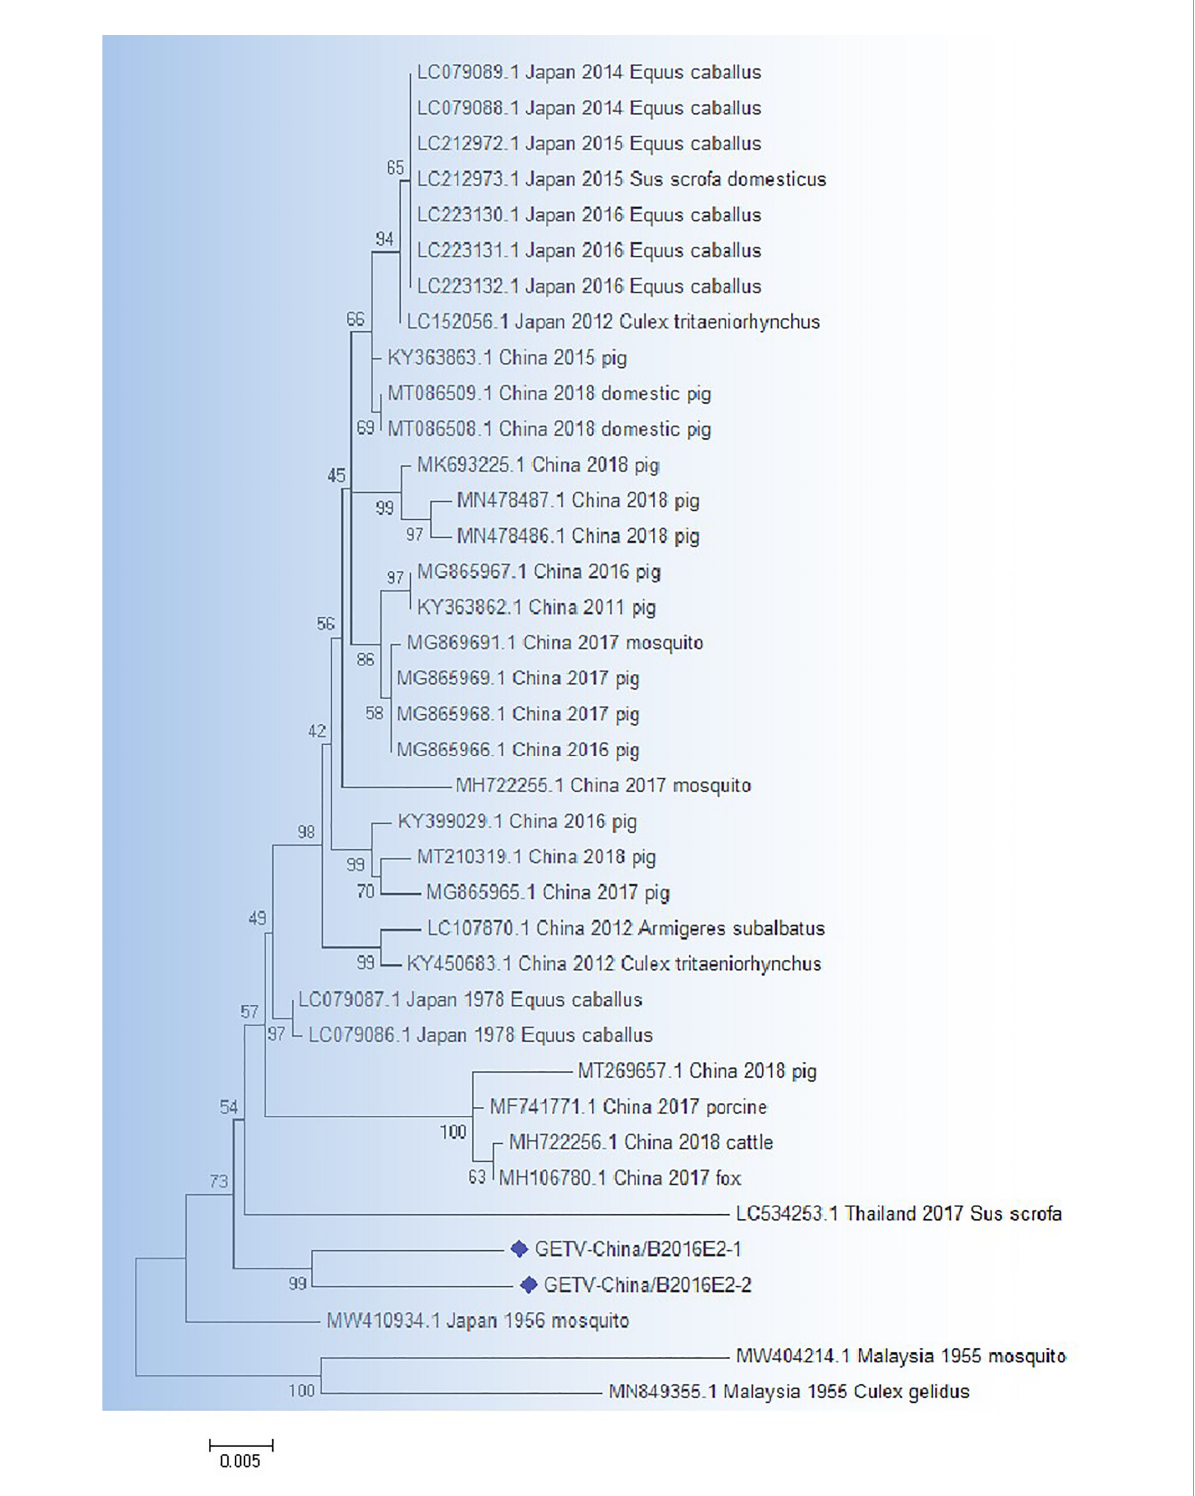
FIGURE 4 The phylogenetic analysis based on GETV-E2. Complete E2 gene sequences with 1266 nt of GETV were used for phylogenetic analysis. The maximum likelihood method was used tree building algorithms in MEGA 7.0, with bootstrap value set to 1,000. Solid blue rhombus was used for marking the viral genes ampli fi ed in the